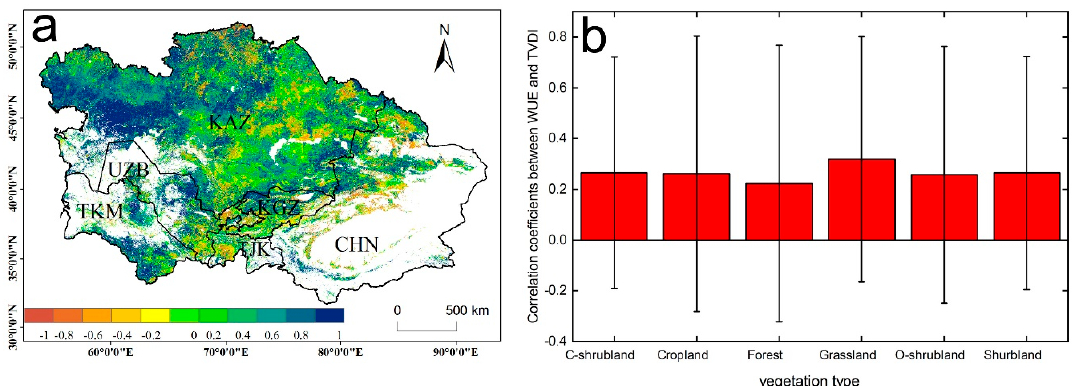
Figure 8. ( a ) Correlation between WUE and TVDI for the period 2011–2014; ( b ) correlations for the different vegetation types. White areas represent barren, snow, and water body